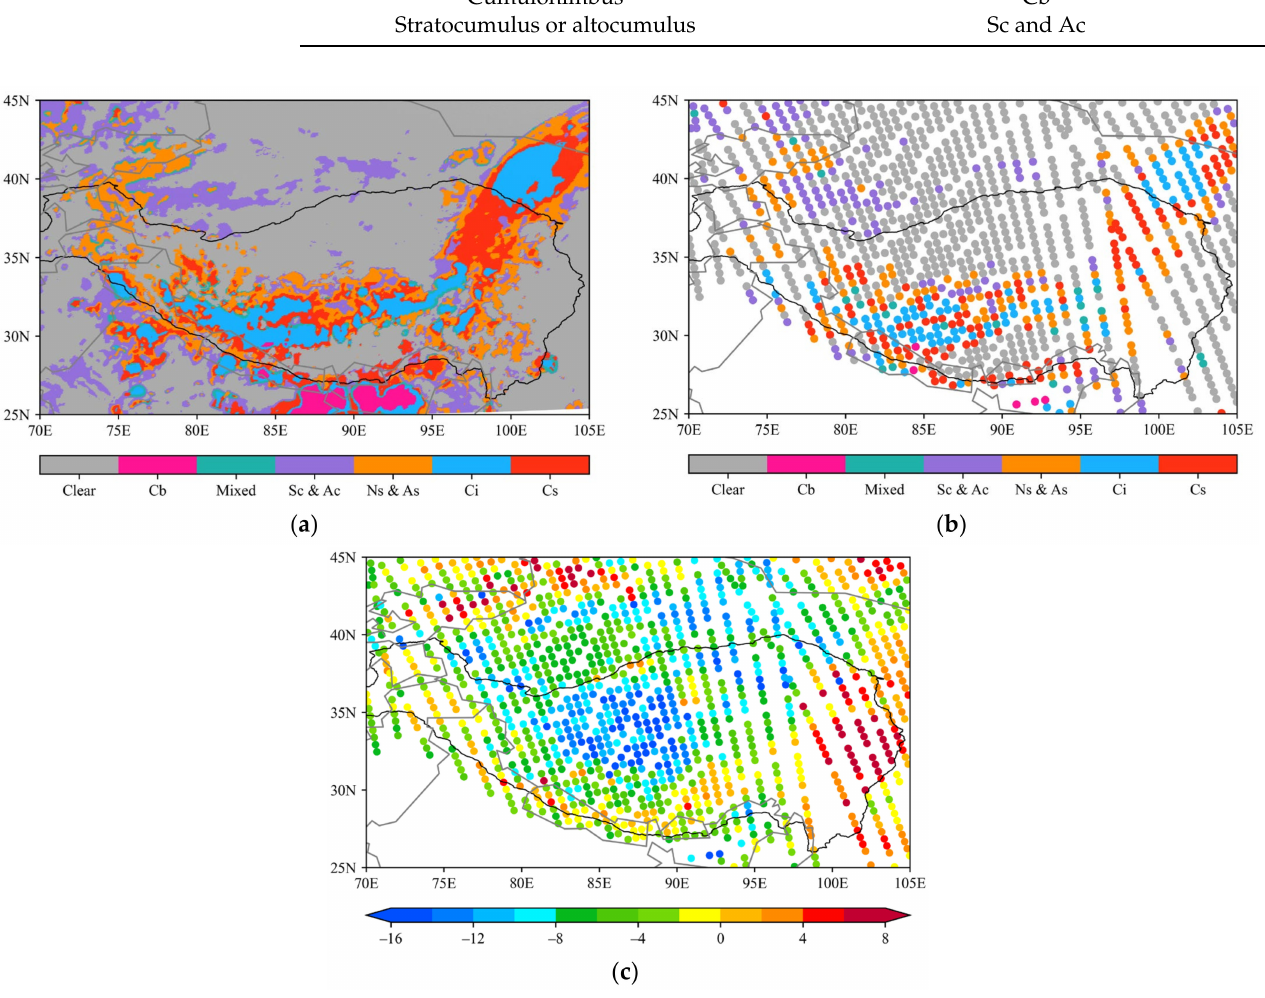
Figure 2. The ( a ) VISSR-II cloud classification products, ( b ) matched cloud classification products, and ( c ) spatial distribution of O − B (unit: K) of AMSU-A channel 3 over the Tibetan Plateau region at 1200 UTC 12 August